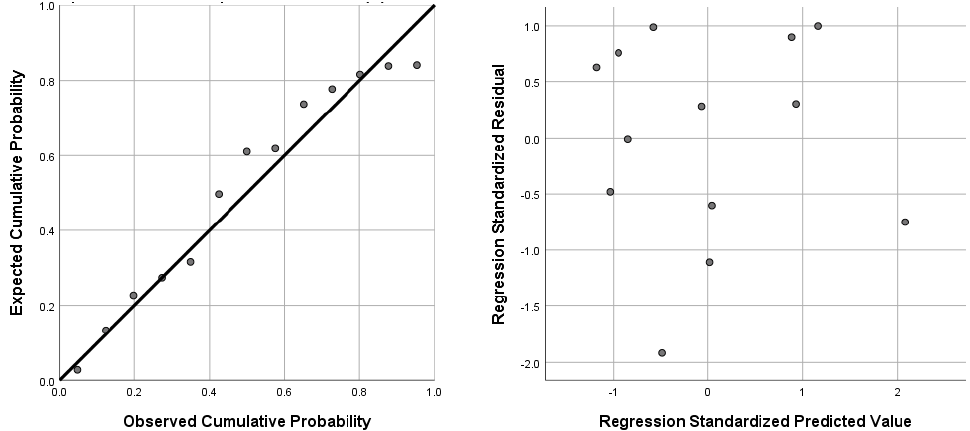
Figure 3. Normality plot of regression standardized residual and homoscedasticity scatter plot of models 2 (bean firmness with trough with brine and setback with brine) and 4 (bean firmness with final viscosity with brine and setback with brine).